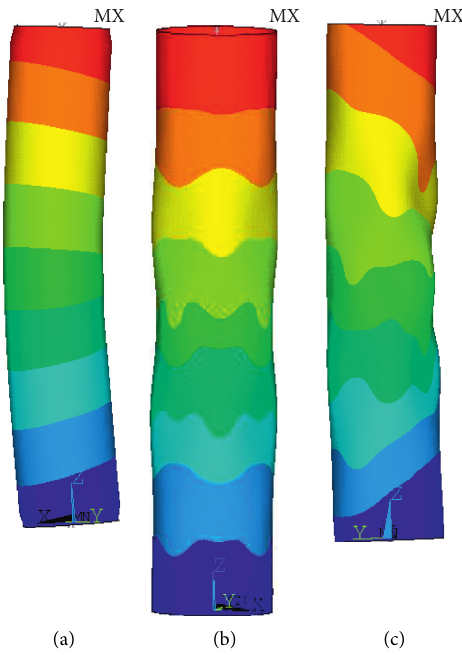
Figure 4: Global and local geometry imperfection. (a) Deformation of FE models introduced overall imperfection. (b) Deformation of FE models introduced local imperfection. (c) Deformation of FE models introduced overall and local imperfection.